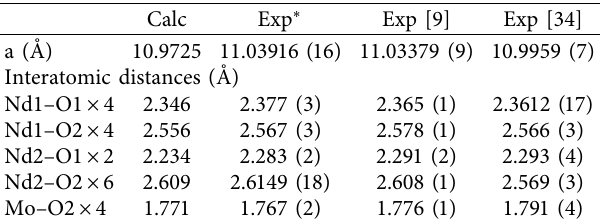
Table 6: Experimental and calculated unit cell parameters